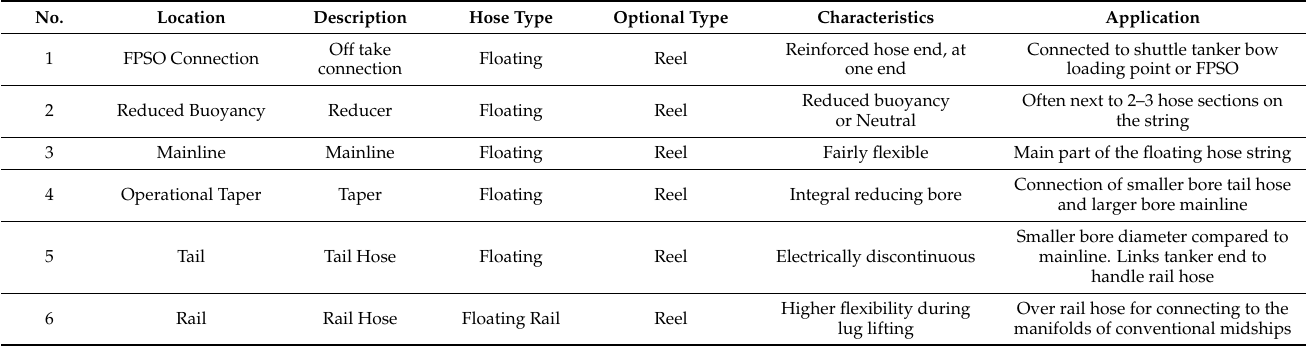
Figure 13. Tandem mooring floating hose configuration. Table 3. Arrangement of tandem mooring floating hoses.